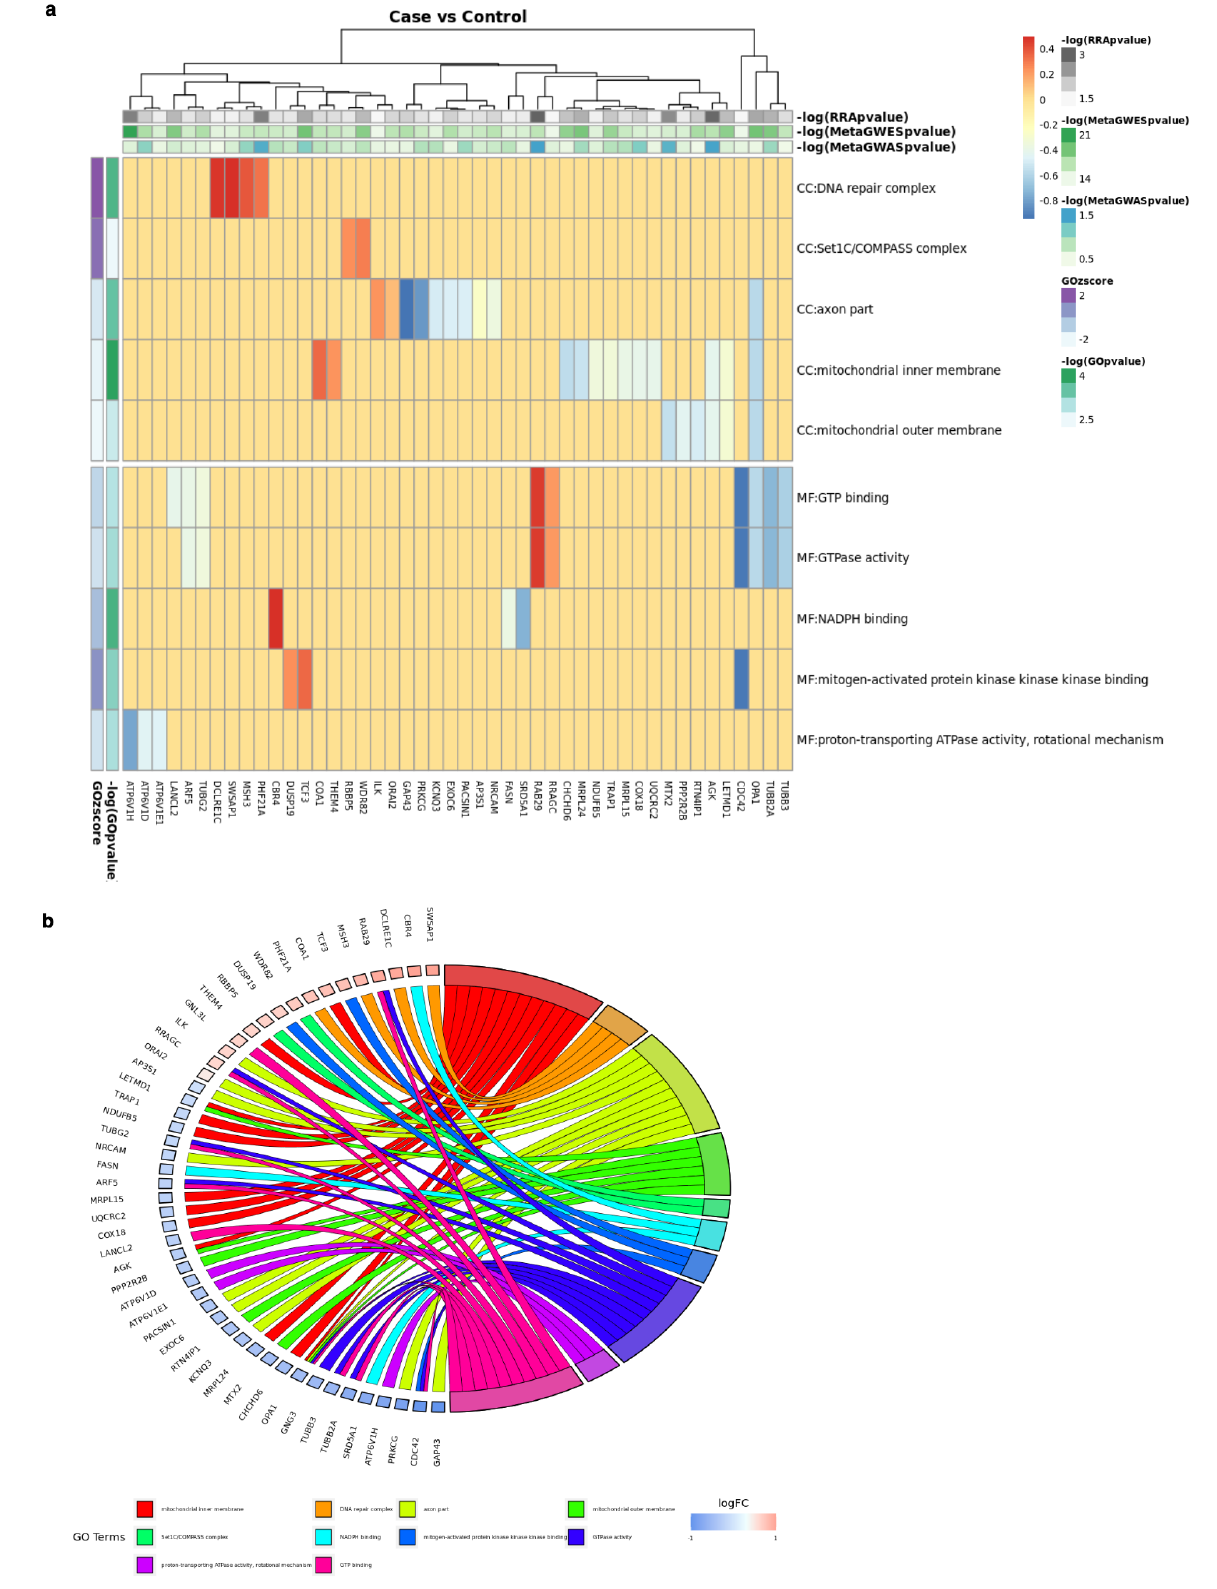
Figure 9. Functional analysis of results: over-representation pathway analysis. ( a ) case vs. control ( b ) Go